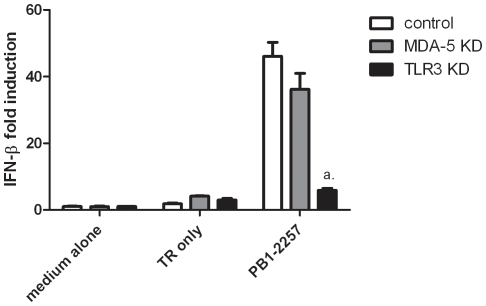
T7-PB1-2257 requires TLR3 but not Mda5 for type I IFN induction in DF-1 cells.Control (white bars), Mda5-knockdown (striped bars) and TLR3-knockdown (black bars) DF-1 cells were transfected with PB1-2257 (T7-siRNA, 20 pmol). mRNA levels of IFN-β were measured by QRT-PCR 24 h after PB1-2257 stimulation. a = p<0.001 between IFN-β levels induced by PB1-2257 in control cells (white bars) and TLR3 KD cells (black bars). Results are representative of 3 separate experiments.